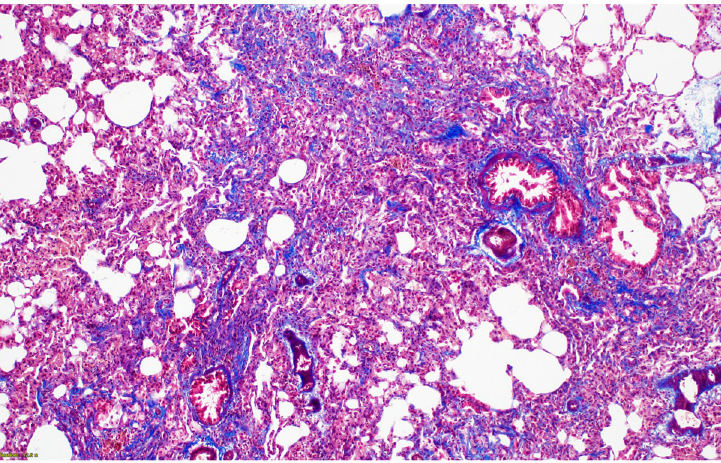
Fig 10. The histologic findings of lung fibrosis at 52 weeks after PHMG exposure. Increased fibrosis with definitive damage to lung structure and formation of fibrous bands are shown (Ashcroft score 5) (MT stain, x100).